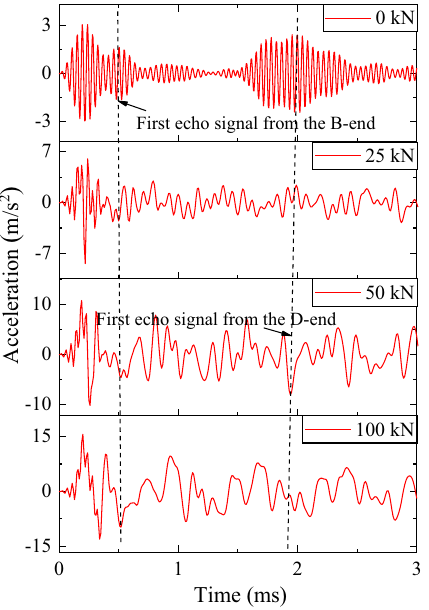
Fig. 14 Wave propagation signal with different bond length under dif- ferent pull-out loads